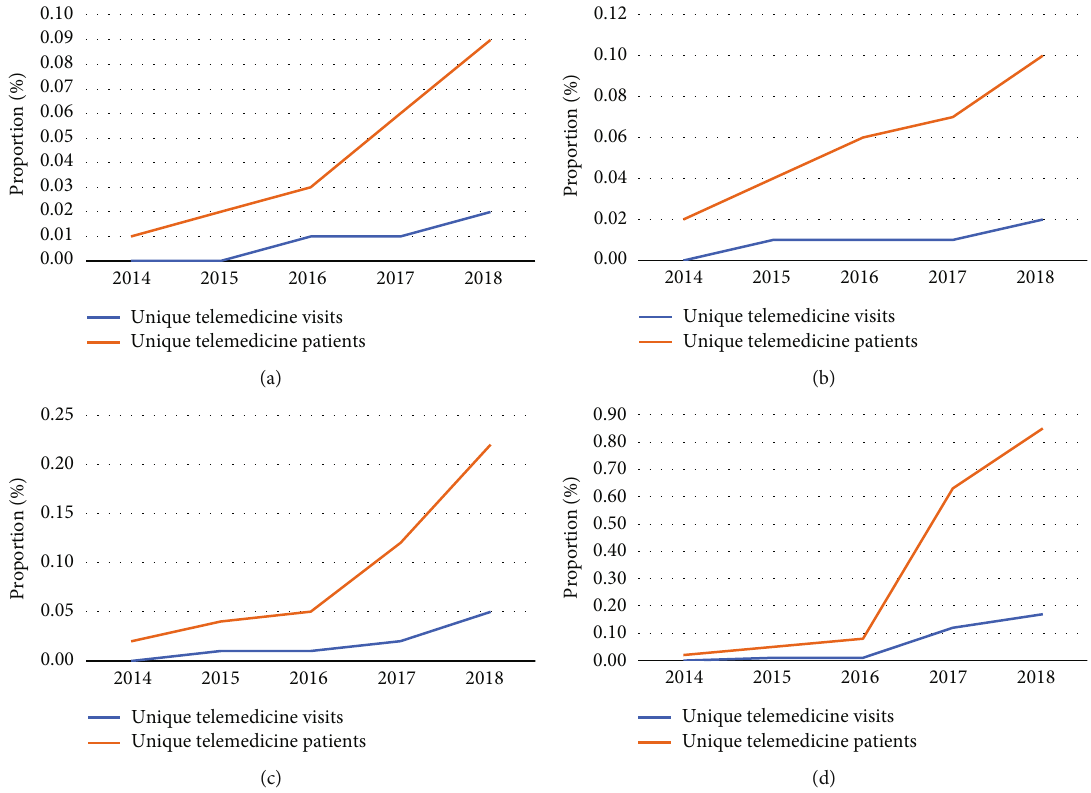
Figure 4: Trends in unique telemedicine visits/patients by region: (a) northeast, (b) north central, (c) south, and (d)